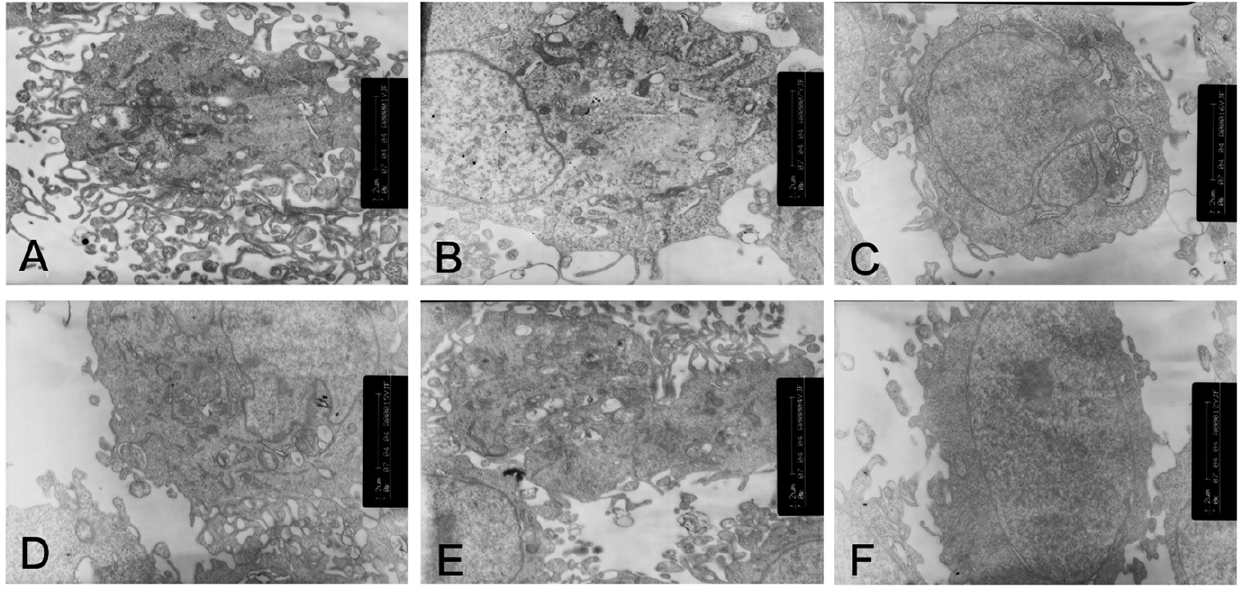
Figure 3. Transmission electron microscopic analysis of the HK-2 cells cultured under different conditions. (A–C)The HK-2 cells under 30 mM glucose (B) or 30 mM glucose + Cont siRNA (C) showed decreased number of microvilli, mitochondria and increased volume density of rough endoplasmic reticulum compared to that of the cells cultured in 5.5 mM glucose(A). (D–F)Changes of the cells were reversed,which were cultured in the 30 mM glucose + p38 siRNA for 24 h(D) or 48 h(E) or 30 mM glucose + AP-1 inhibitor(F).